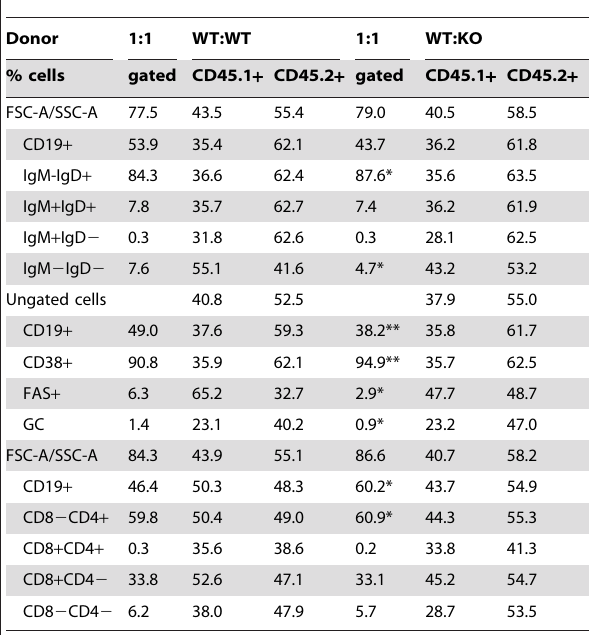
Table 3. FACS analysis of the cellular populations present in the thymus three months after competitive bone marrow transplantation.